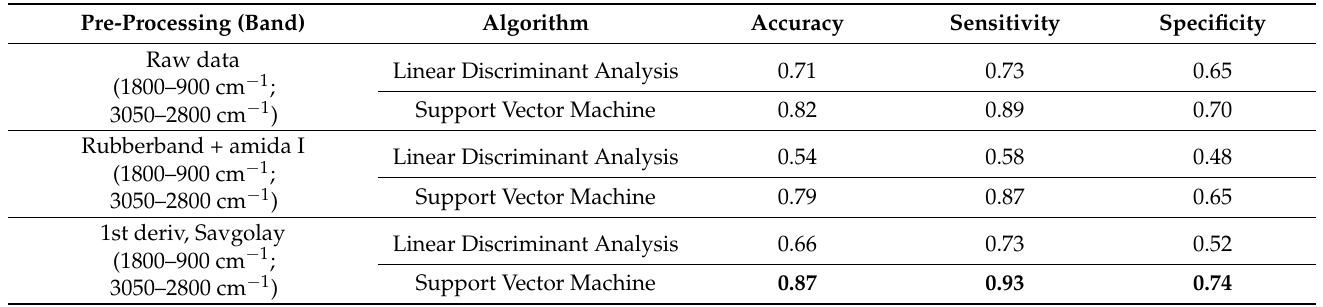
Table 2. Machine learning algorithms applied in salivary spectra to discriminate non-diabetic individuals and uncontrolled type 2 diabetic patients.